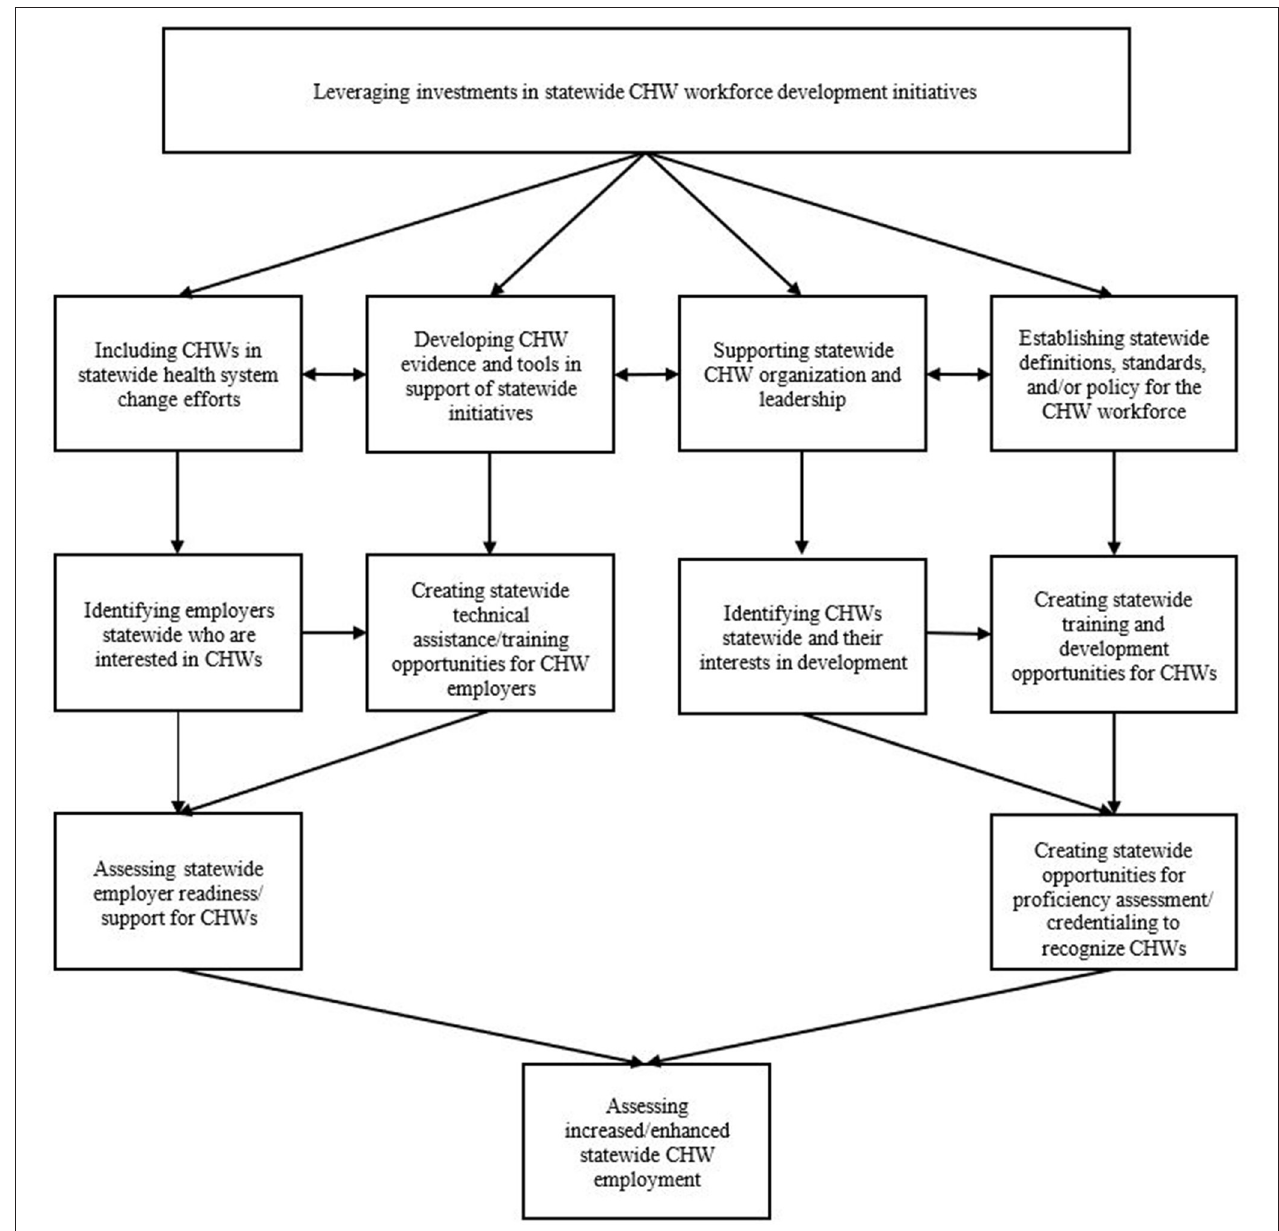
FIGURE 1 | Conceptual model of processes involved in statewide community health worker (CHW) workforce development initiative